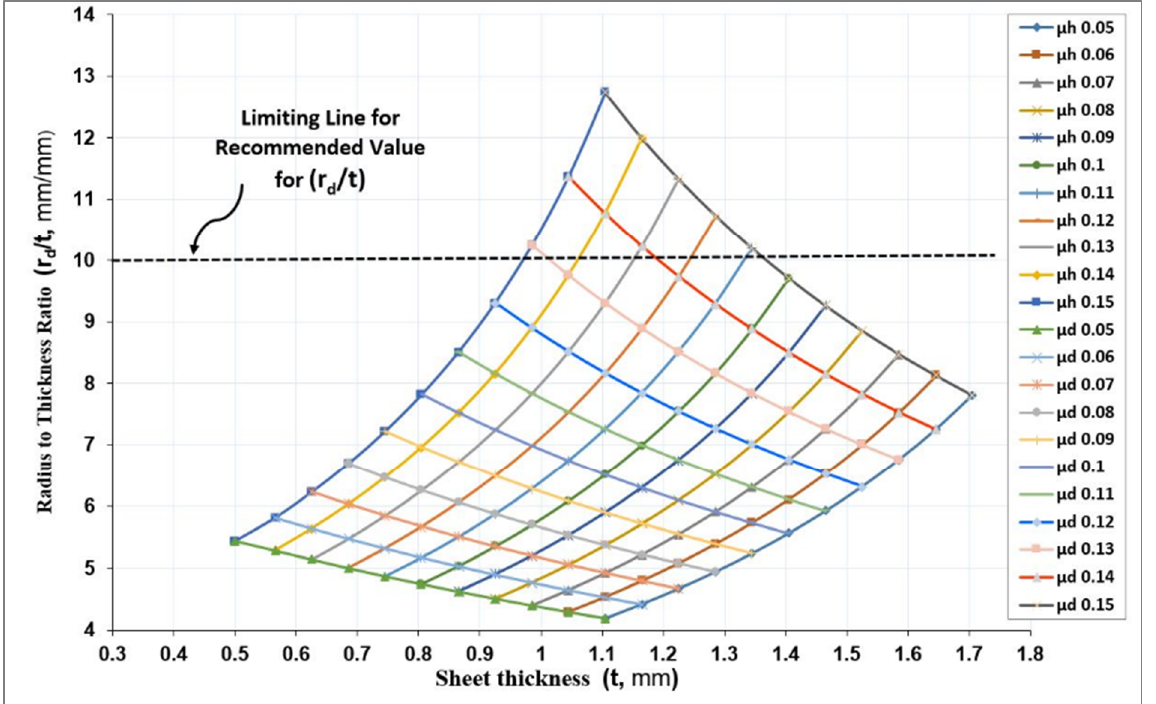
Figure 12. Carpet plot of minimum deep drawing force at different values of radius-to-thickness ratio ( r d /t ), sheet metal thickness ( t ), and friction coefficients ( μ d and μ h ).